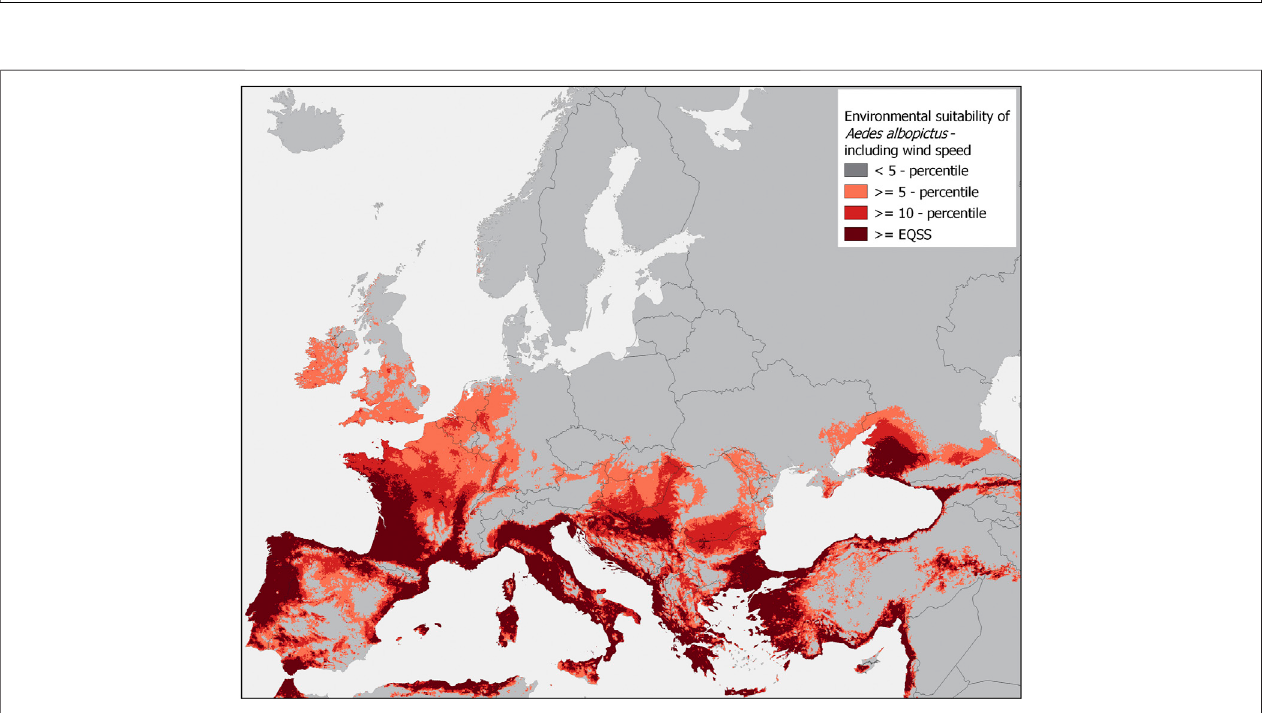
FIGURE 2 | Categorized habitat suitability map of Aedes albopictus in Europe under current climatic conditions based on an ecological niche model ( Model-with- wind speed ) of 7,207 global occurrence localities. Explanatory parameters used for model training include bioclimatic variables (derived from the WorldClim database 6 , theenhancedvegetationindex(derivedfromtheLPDAACdatabase),andwindspeed(derivedfromtheERA5database).Alldatabaseswereaccessedon2September 2021. The habitat suitability map was classi fi ed into binary results, according to three established threshold probability values: the 5-percentile, 10-percentile, and the equal sensitivity and speci fi city threshold (EQSS).